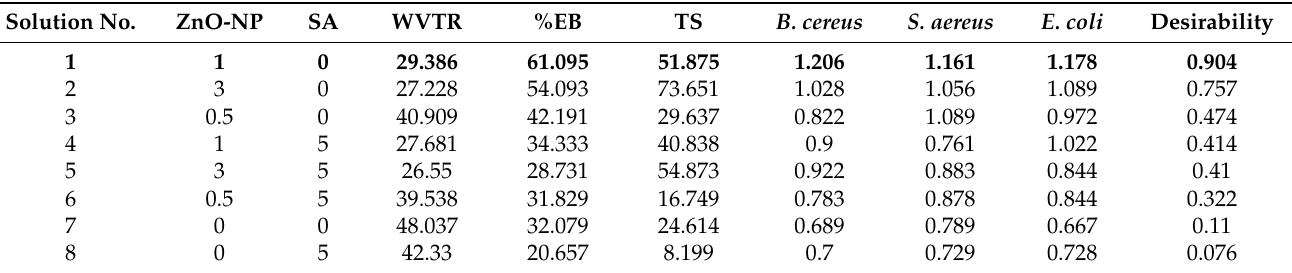
Table 4. Solution of the optimized formula given by DX-13.